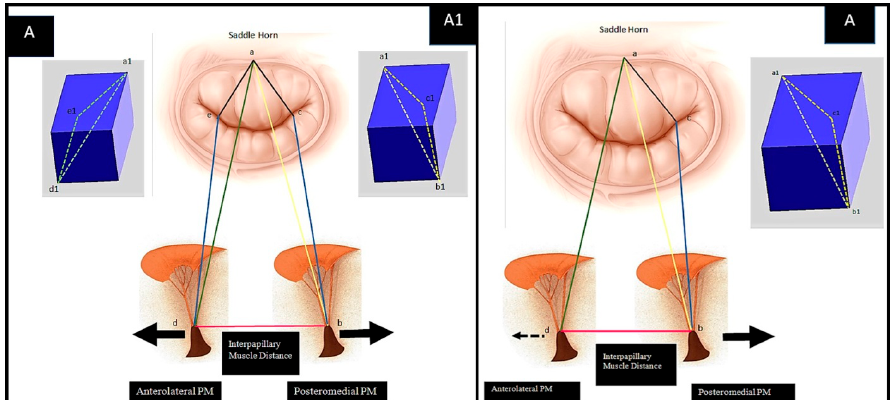
Figure 2. Schematic representation of symmetric and asymmetric pattern of mitral valve tethering. ( Left ) Symmetric tethering pattern. With apical and lateral vector components, the posteromedial papillary muscle and both mitral leaflets are medially displaced, resulting in symmetric leaflet tethering. Of note, primarily apical displacement of both PMs favours less leaflet tethering, while a more medial shift results in increased tethering of both leaflets. (a–b) Posterior PM tethering, distance between the posteromedial PM tip and the saddle horn; (a–d) anterolateral PM tethering, distance between the anterolateral PM tip and the saddle horn; (a–c) anterior component of posterior PM tethering; (b–c) posterior (inferior) component of posteromedial PM tethering; (a–d) anterolateral PM tethering with its components (a–e) and (e–d). ( Right ) Asymmetric tethering pattern. A posterior vector imparts a posterior (major) and apical (minor) displacement of the postero medial papillary muscle (PMPM) resulting in asymmetric tethering. (a–b) Posterior PM tethering, distance between the posteromedial PM tip and the saddle horn; (a–d) anterolateral PM tethering, distance between the anterolateral PM tip and the saddle horn; (a–c) anterior component of posterior PM tethering; (b–c) posterior (inferior) component of posteromedial PM tethering; (a–d) anterolateral PM tethering is less implicated and characterized by apical and posterolateral components. A and A1—tetrahedron representation of symmetric tethering pattern. A—tetrahedron representation of posteromedial PM symmetric tethering. Symmetric anterior and posterior leaflet tethering. A + A1—tetrahedron representation both of